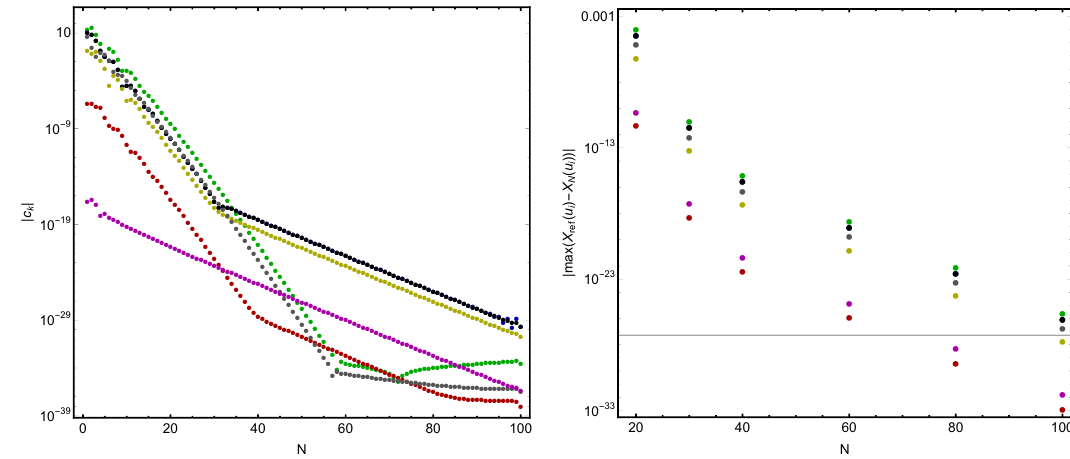
Figure 3 . The fluctuations h tt , h tz , h xx , h yy , h zz , a t , a z = (green, red, blue, black, yellow, gray, magenta) for h tt (0) = 1 , µ/T = 61 . 062 , k/T = 0 . 0002655 . Left: Chebyshev coefficients of the numerical solution. Right: maximal deviation from the numerical solution with N = 130 grid- points evaluated on an equidistant grid as function of the number of